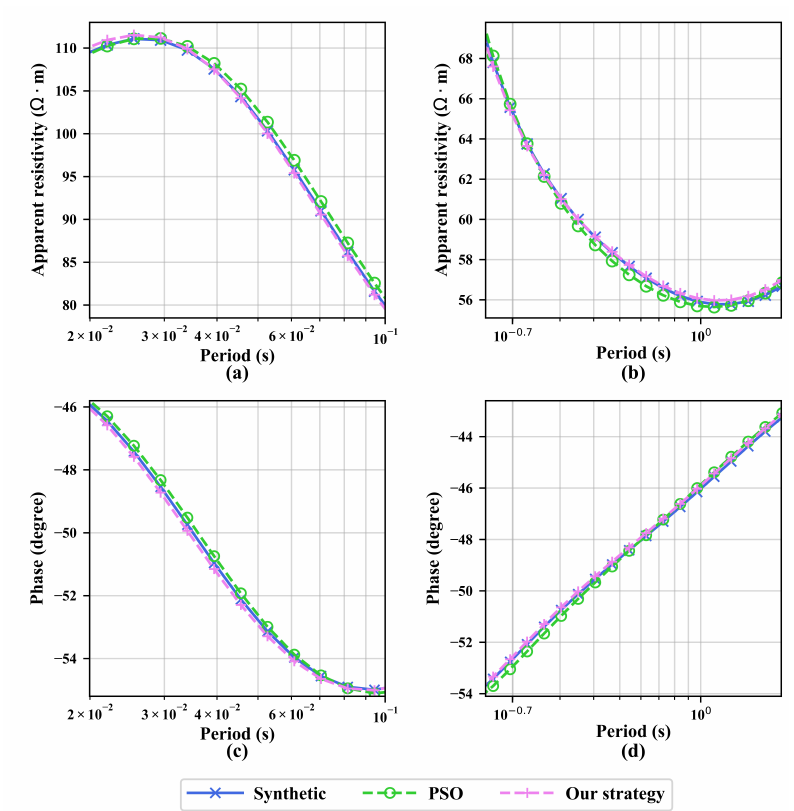
Figure 7. Comparison of the MT response in special frequency bands for the five-layer model. ( a , b ) represent apparent resistivity curves, and ( c , d ) represent phase curves. The blue lines represent the supposed MT responses. The green lines represent the MT responses predicted by traditional PSO. The purple lines represent the MT responses predicted by our strategy.